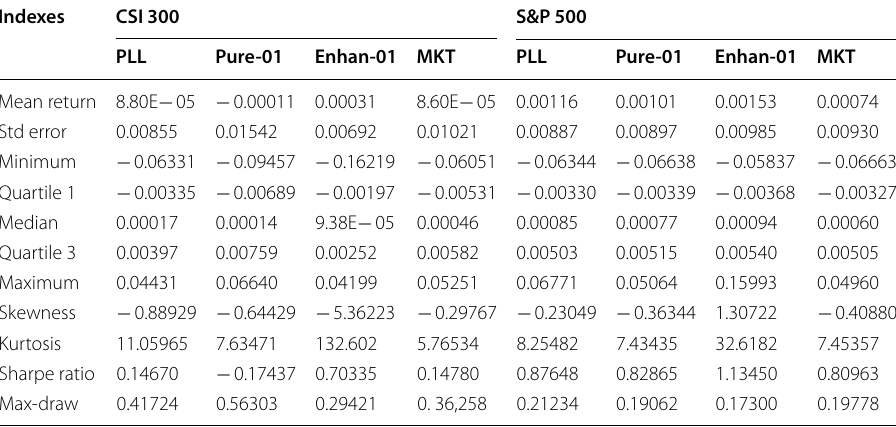
“Max-draw” is an abbreviation for “maximum